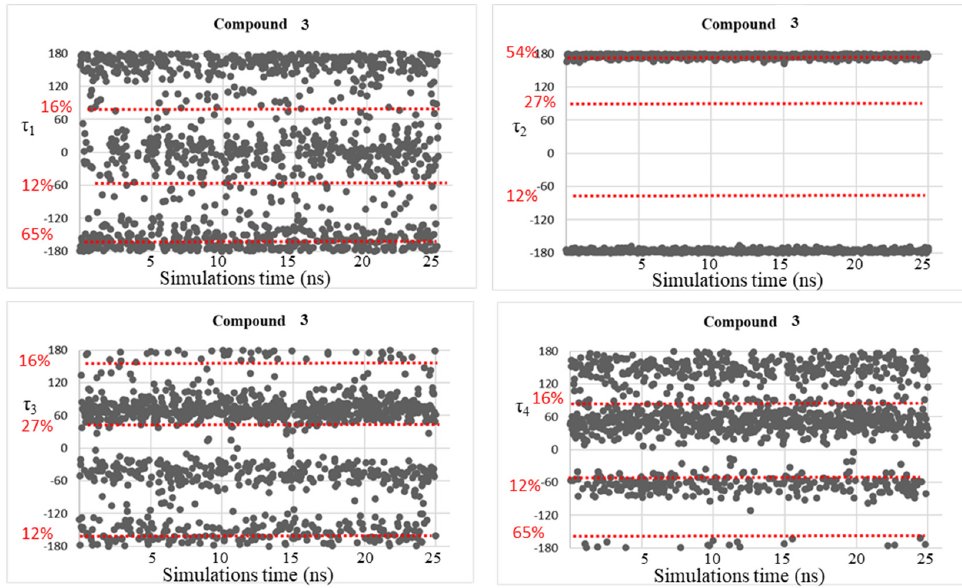
Figure 6. Dihedral torsion angle values τ 1 , τ 2 , τ 3 , and τ 4 of compound 2 over the MD simulations. The red dotted line highlights the torsional angles values found by DFT calculations in the most populated energy minima. The red label on the left displays the corresponding population percent- age.